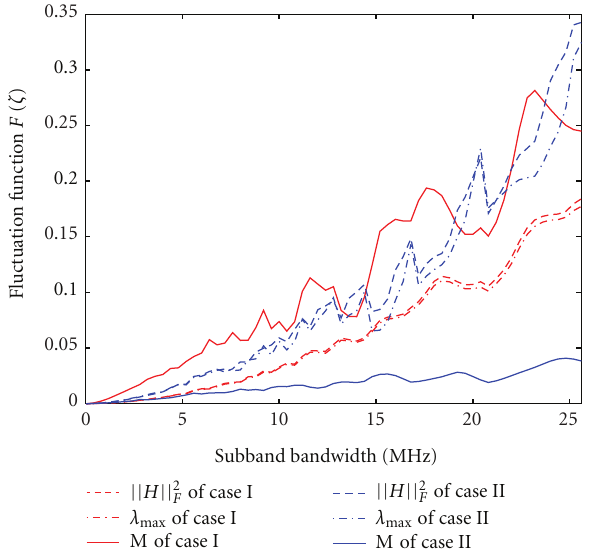
Figure 9: The fluctuation level variations of the key channel metrics.